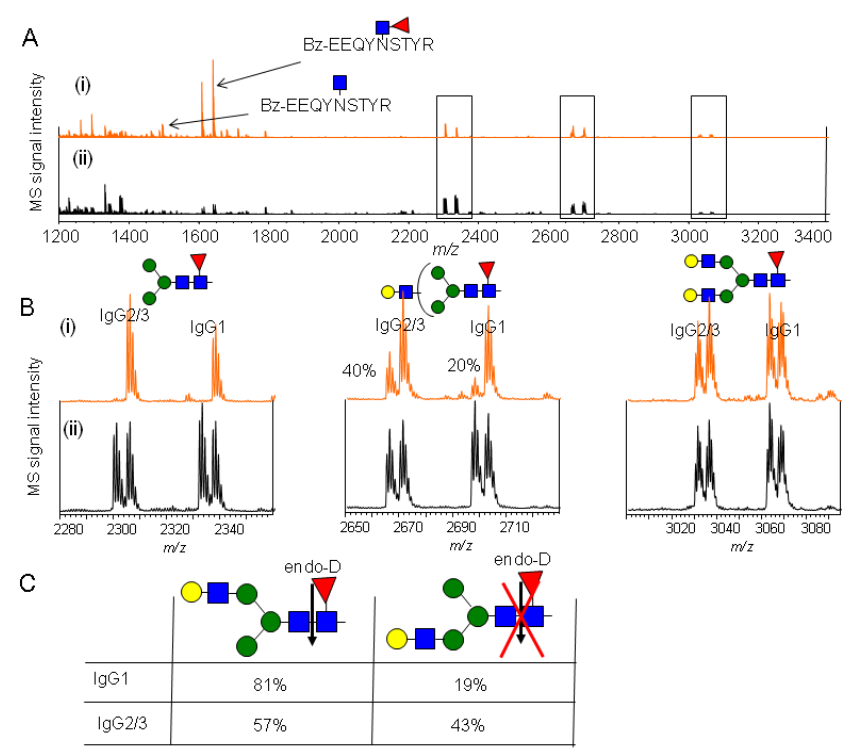
Figure 6. ( A ) MALDI-TOF MS spectra of (i) an equimolar mixture of Bz-labeled hIgG glycopeptides reacted with both β -GlcNAc’ase and endo-D, and d-Bz-labeled hIgG glycopeptides reacted with only β -GlcNAc’ase (ii) an equimolar mixture of Bz-labeled hIgG glycopeptides reacted with only β -GlcNAc’ase and d-Bz-labeled hIgG glycopeptides reacted with only β -GlcNAc’ase; ( B ) Enlarged spectra of glycopeptides containing glycoforms on the IgG1 and IgG2/3